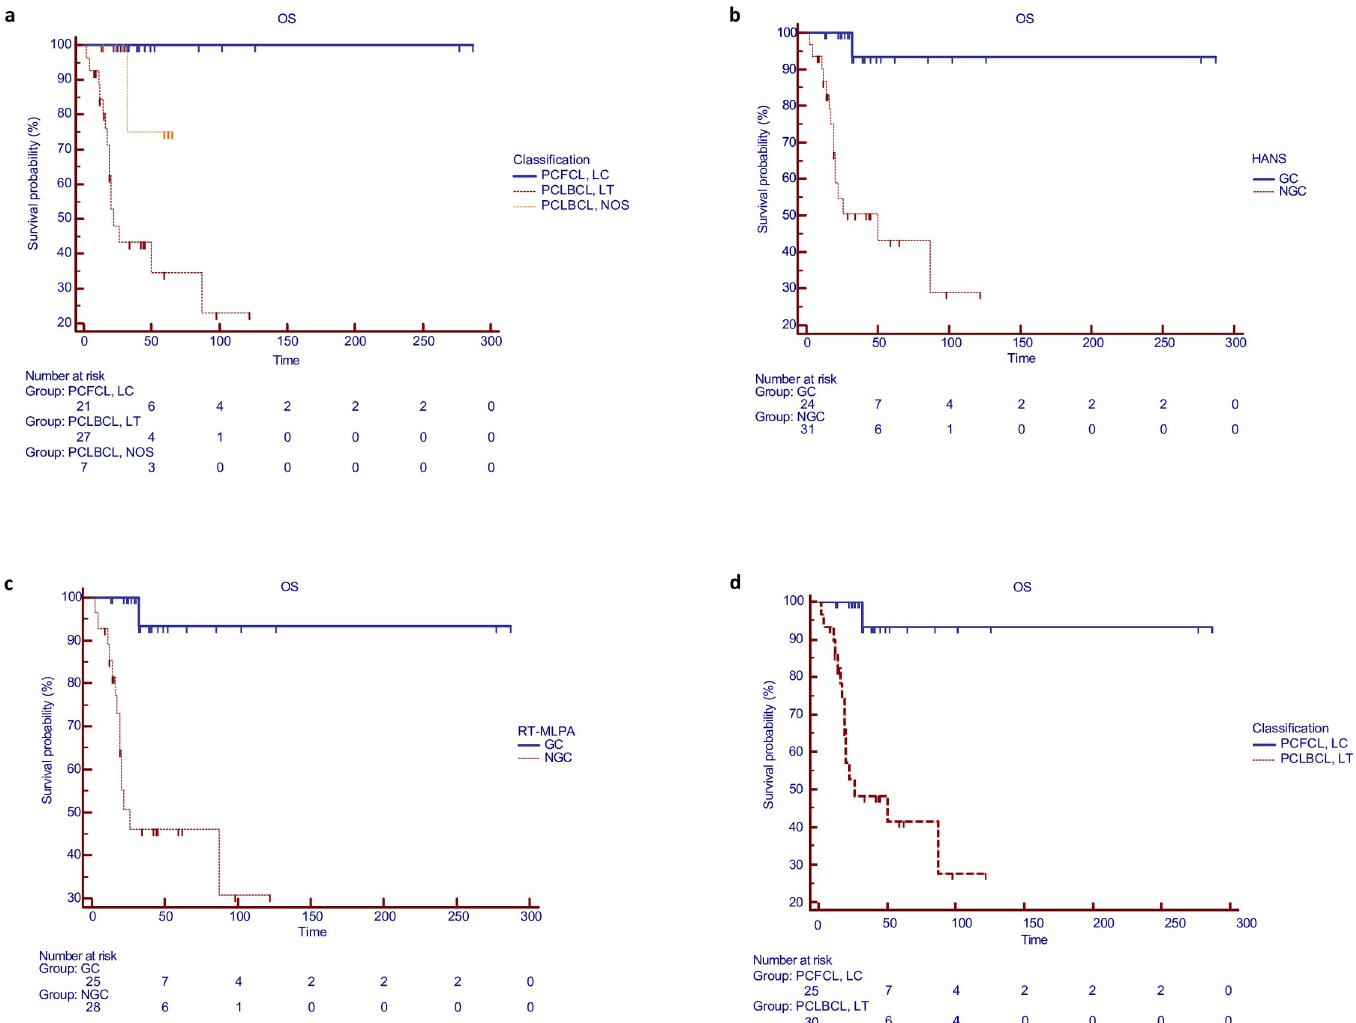
Fig 3. Survival analysis according to the histopathological diagnosis or to the molecular profiling. a. Overall survival (OS) according to the 3 categories of PCLBCL classified according to the 2018 WHO-EORTC criteria. b. OS according to GC and non-GC subtypes defined by Hans’algorithm. c. OS according to GC and non-GC subtypes defined by RT-MLPA assay. d. OS according to the classification by integrative molecular analysis. PCLBCL, LT: primary cutaneous large B-cell lymphoma, leg type; PCFCL, LC: primary cutaneous follicle centre lymphoma, large cell; PCLBCL, NOS: primary cutaneous large B-cell lymphomas, not otherwise specified; OS: overall survival; GC: germinal centre; non-GC: non germinal